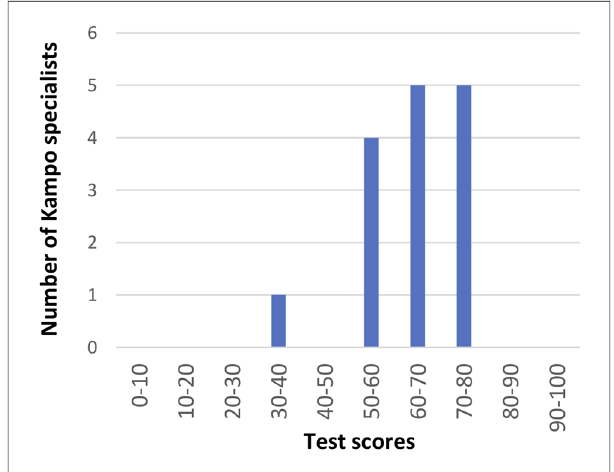
FIGURE 4 Results of the tongue diagnosis test (Study 1): Distribution of test scores for 15 KSs. The average score was 62.2±10.7